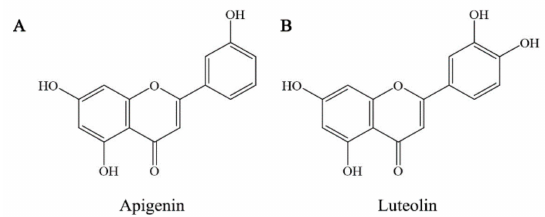
Figure 1. The chemical structures of flavone compounds apigenin and